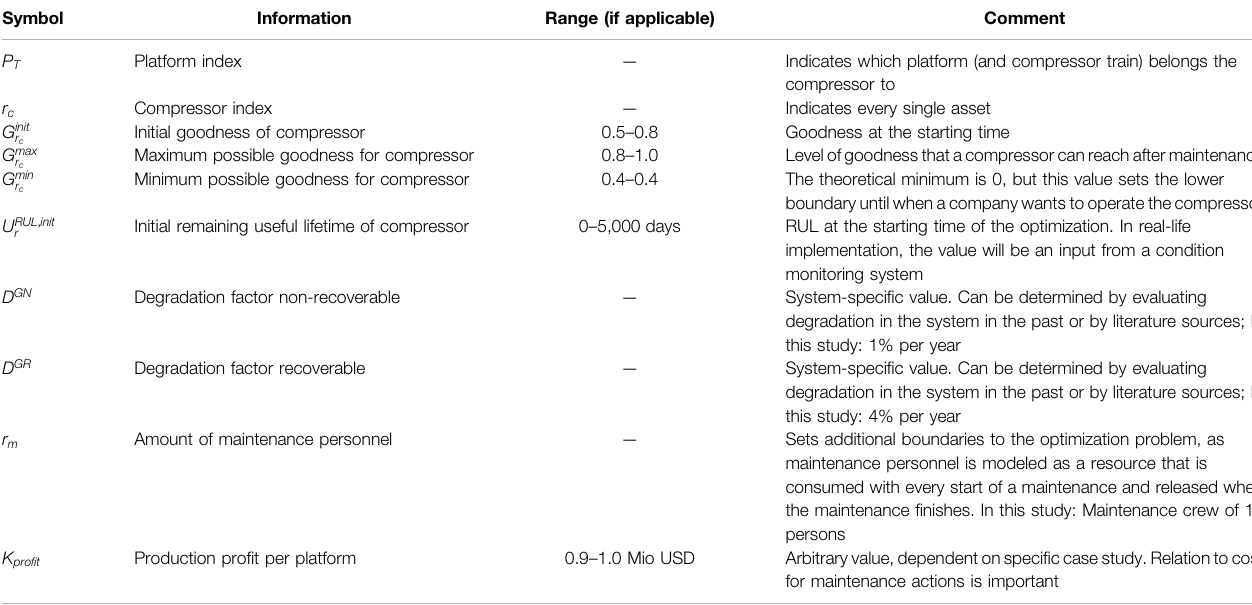
TABLE 1 | Overview of different parameters of the case study.